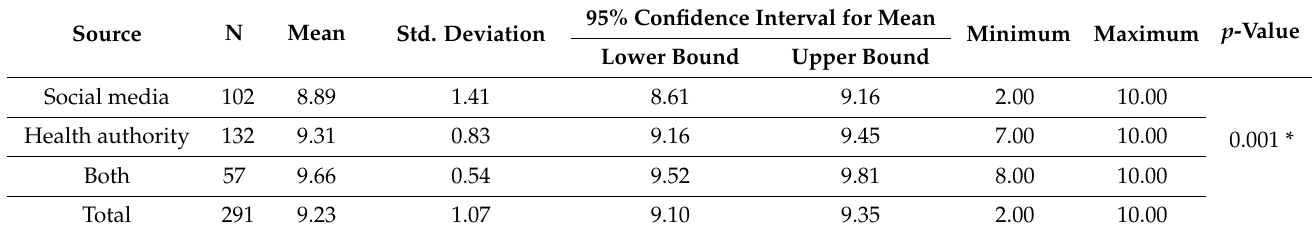
Table 2. Comparison of sources of information based on overall mean scores achieved by pediatric dentists.